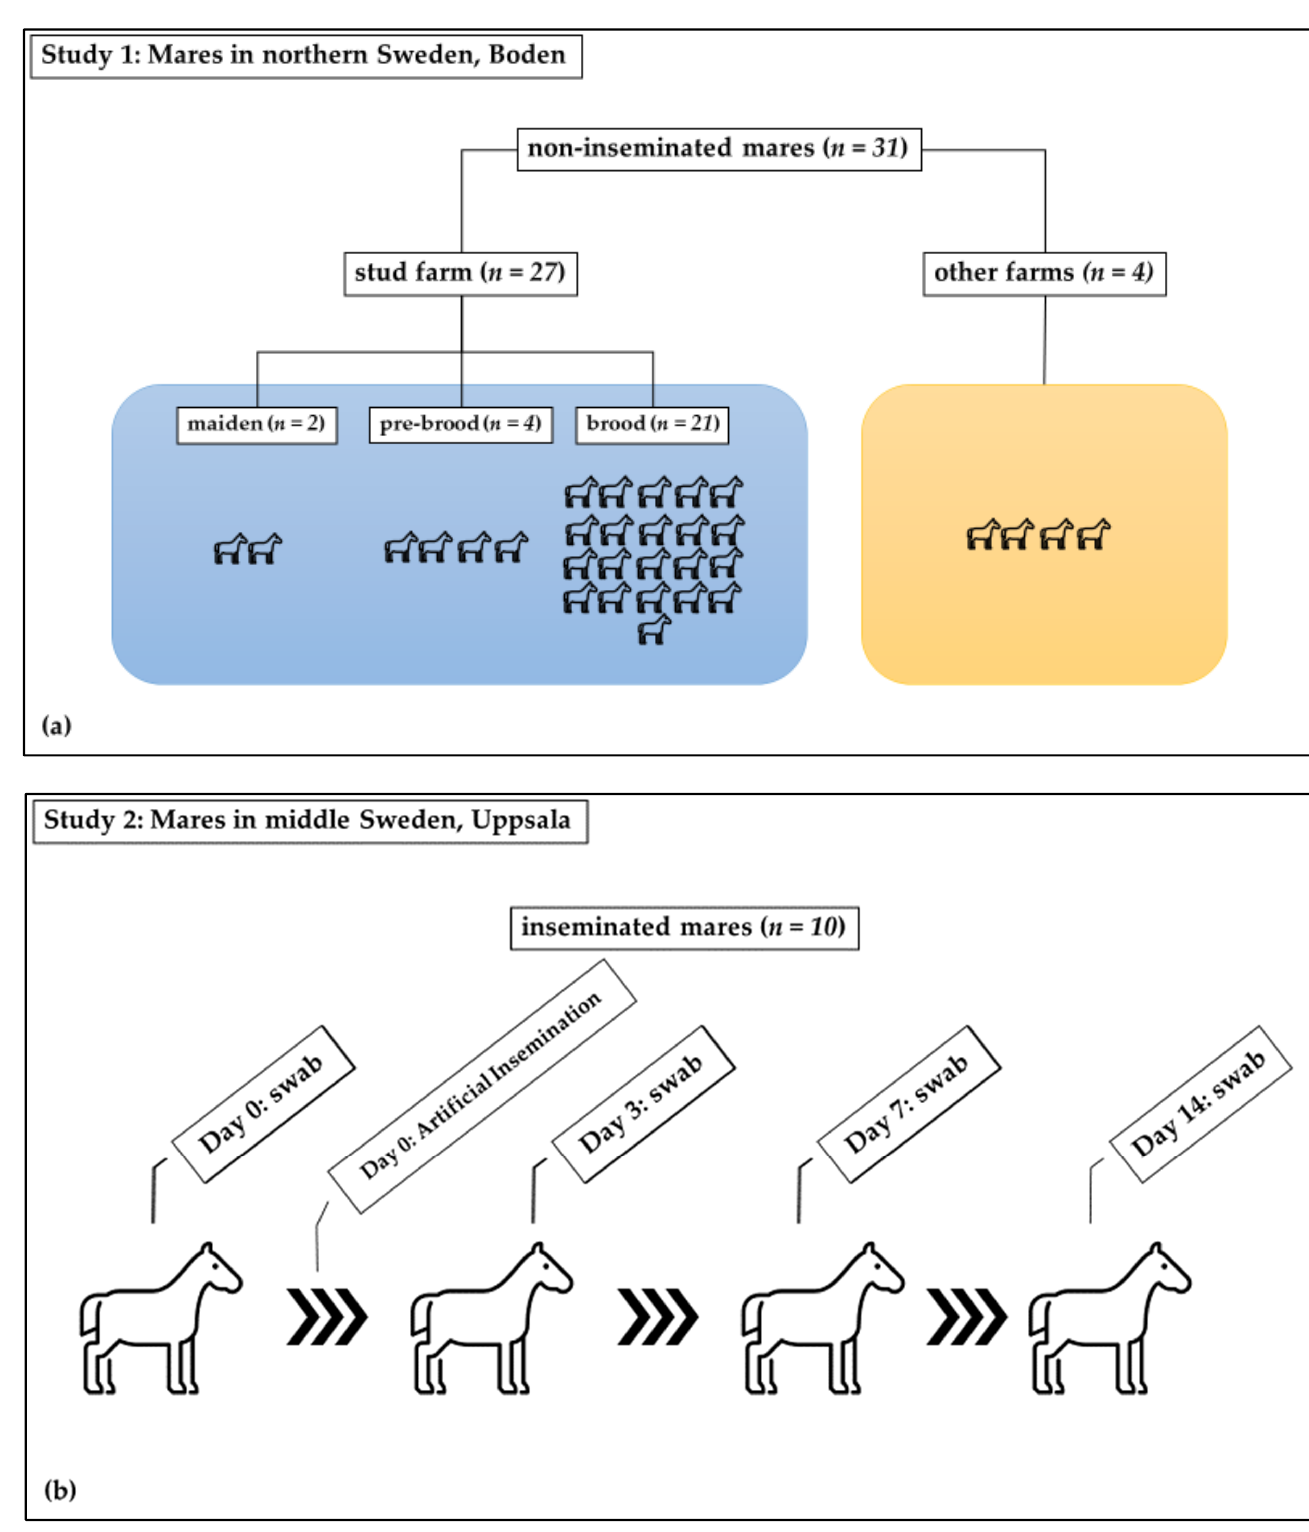
Figure 1. Distribution of mares in study groups: ( a ) Study 1: Non-inseminated mares were sampled once; ( b ) Study 2: Sham-inseminated mares were sampled on Day 0 (before insemination) and on days 3, 7, and 14 after insemination.